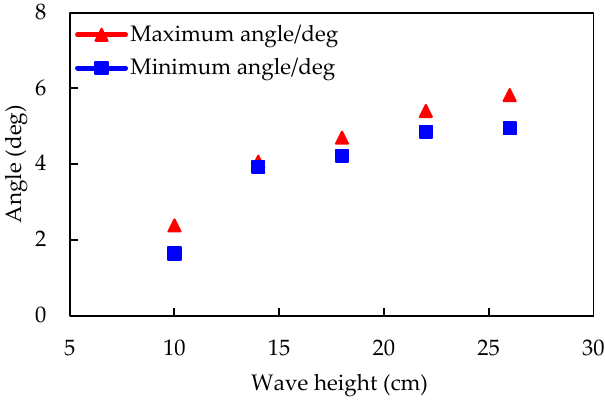
Figure 18. Angle response under different wave heights at 2 s wave period.